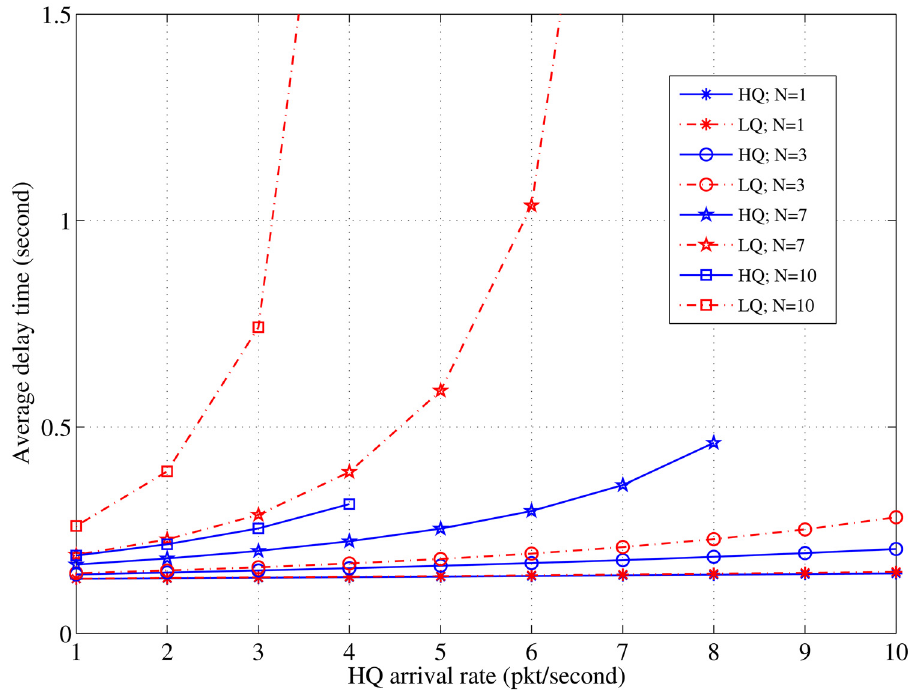
Fig 4. Relationship between λ HQ and the delay in case of various values of N ; τ off = 0.5, λ LQ = 3 [pkt/ sec].